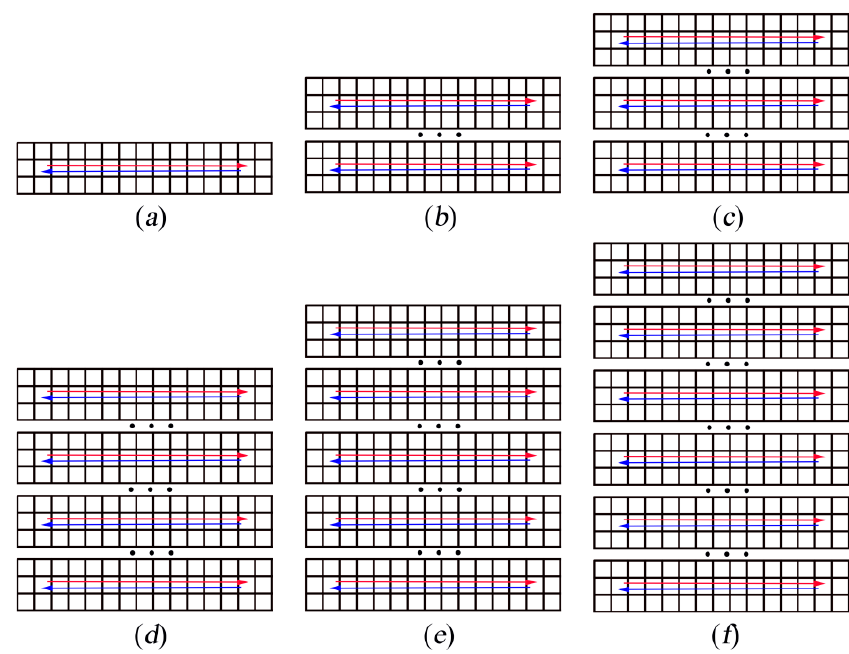
Figure 6. ( a – f ) Schematic diagrams of the start and end positions of the six cases. The position pointed to by the arrow is the end position of each robot. Three dots indicate that seven rows of grids were omitted.